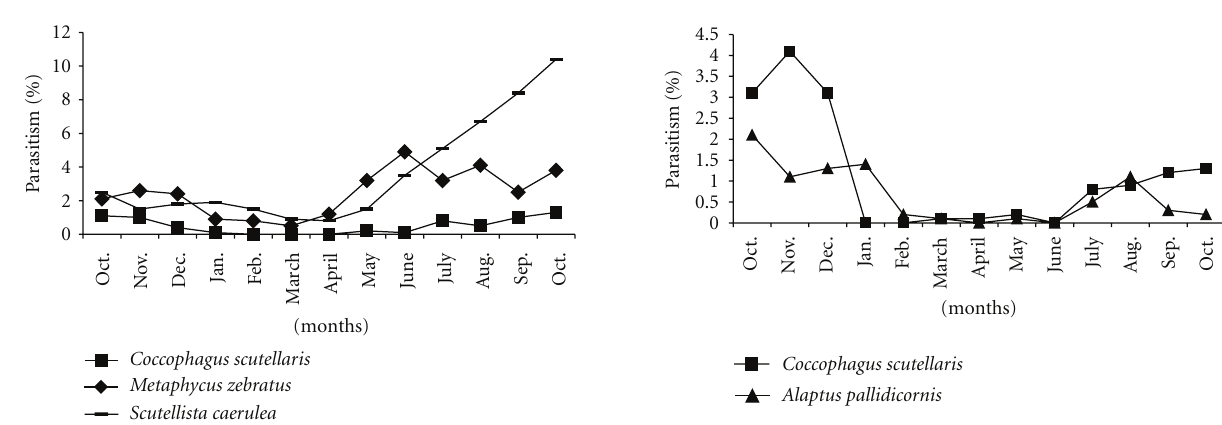
Figure 4: Percent parasitism of Coccophagus scutellaris and other associated parasitoids of Ceroplastes rusci on citrus in Beni Seuf governorate before releasing during 2009-2010.